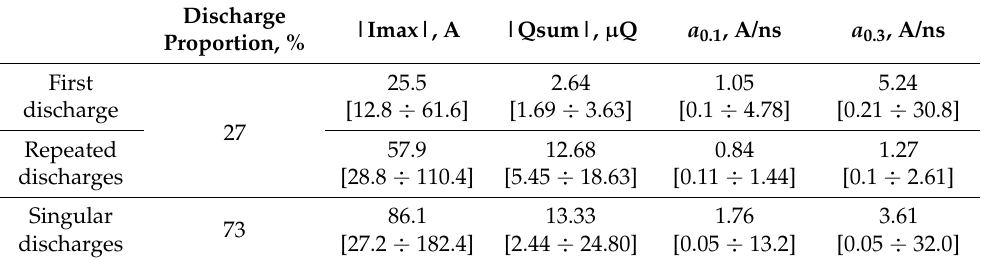
Figure 7. Characteristic dynamics of single discharge formation from an artificial thunderstorm cell of positive polarity with the participation of lower and upper groups of model hydrometeors (frame size 75 × 75 cm, frame duration 1.5 μ s, pause between frames 0.1 μ s). Table 3. Parameters of main stage discharge current pulses from the system of artificial thundercloud cells of positive polarity involving one group of model hydrometeors (mean value,